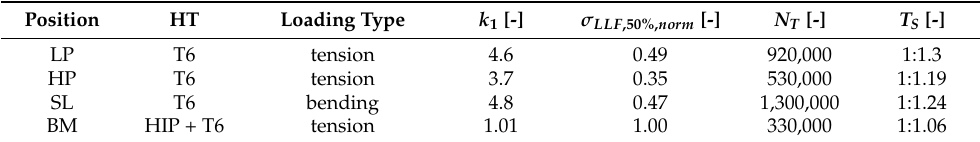
Figure 11. Comparison of normalized S/N-curves for P Occ = 50% experimentally determined within the framework of this study. Table 5. Results of the fatigue tests of the investigated